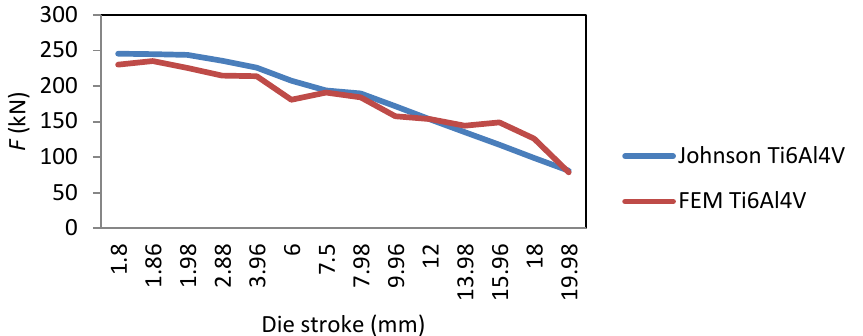
Appl. Sci. 2020 , 10 , x FOR PEER REVIEW Figure 4. Comparison chart between Johnson and FEM extrusion force for a billet of Ti6Al4V.